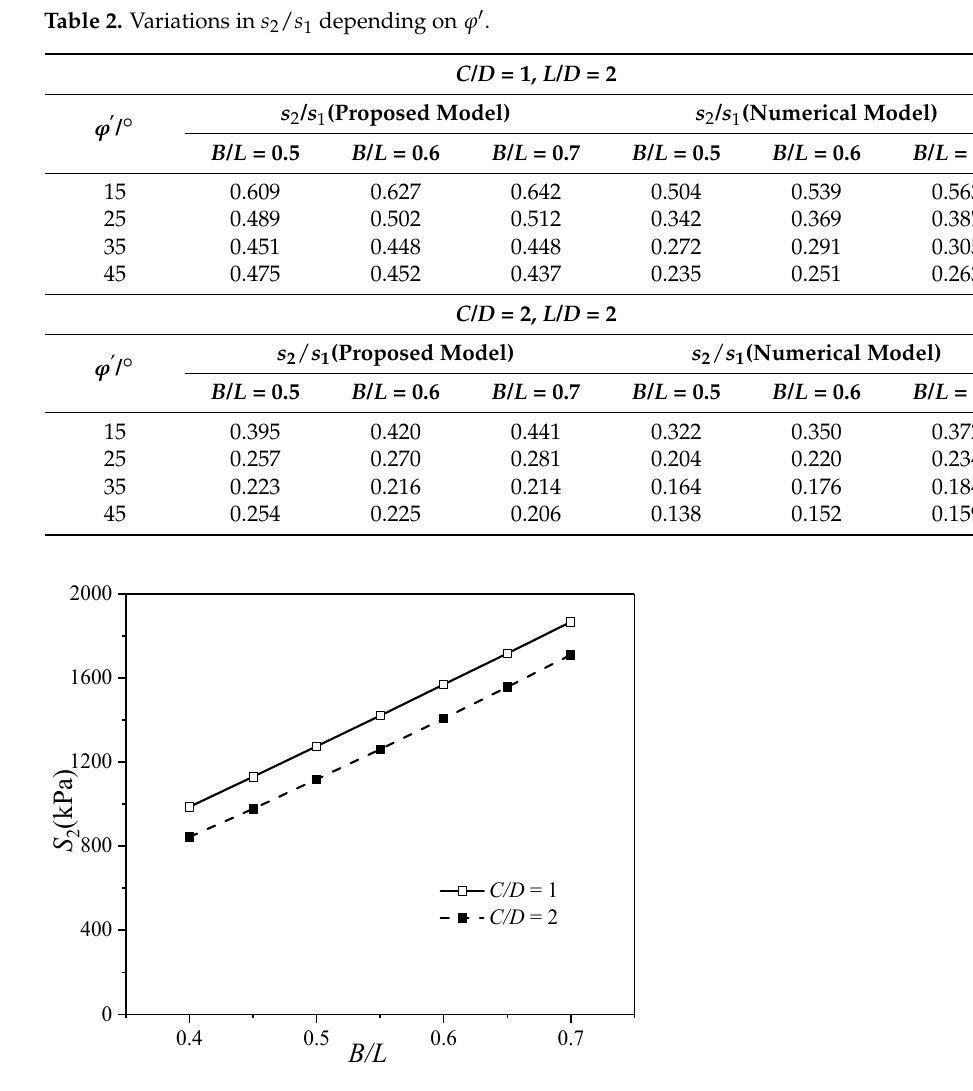
S Figure 9. Variation in S 2 depending on B / L at typical ϕ = 25 ◦ , L / D = depending on Figure 9. Variation in 2